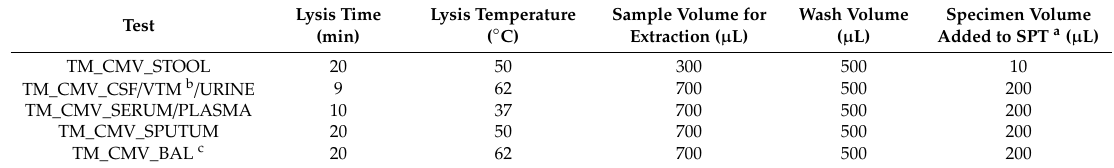
Table 1. Extraction conditions for the BD MAX instrument for di ff erent specimen types.